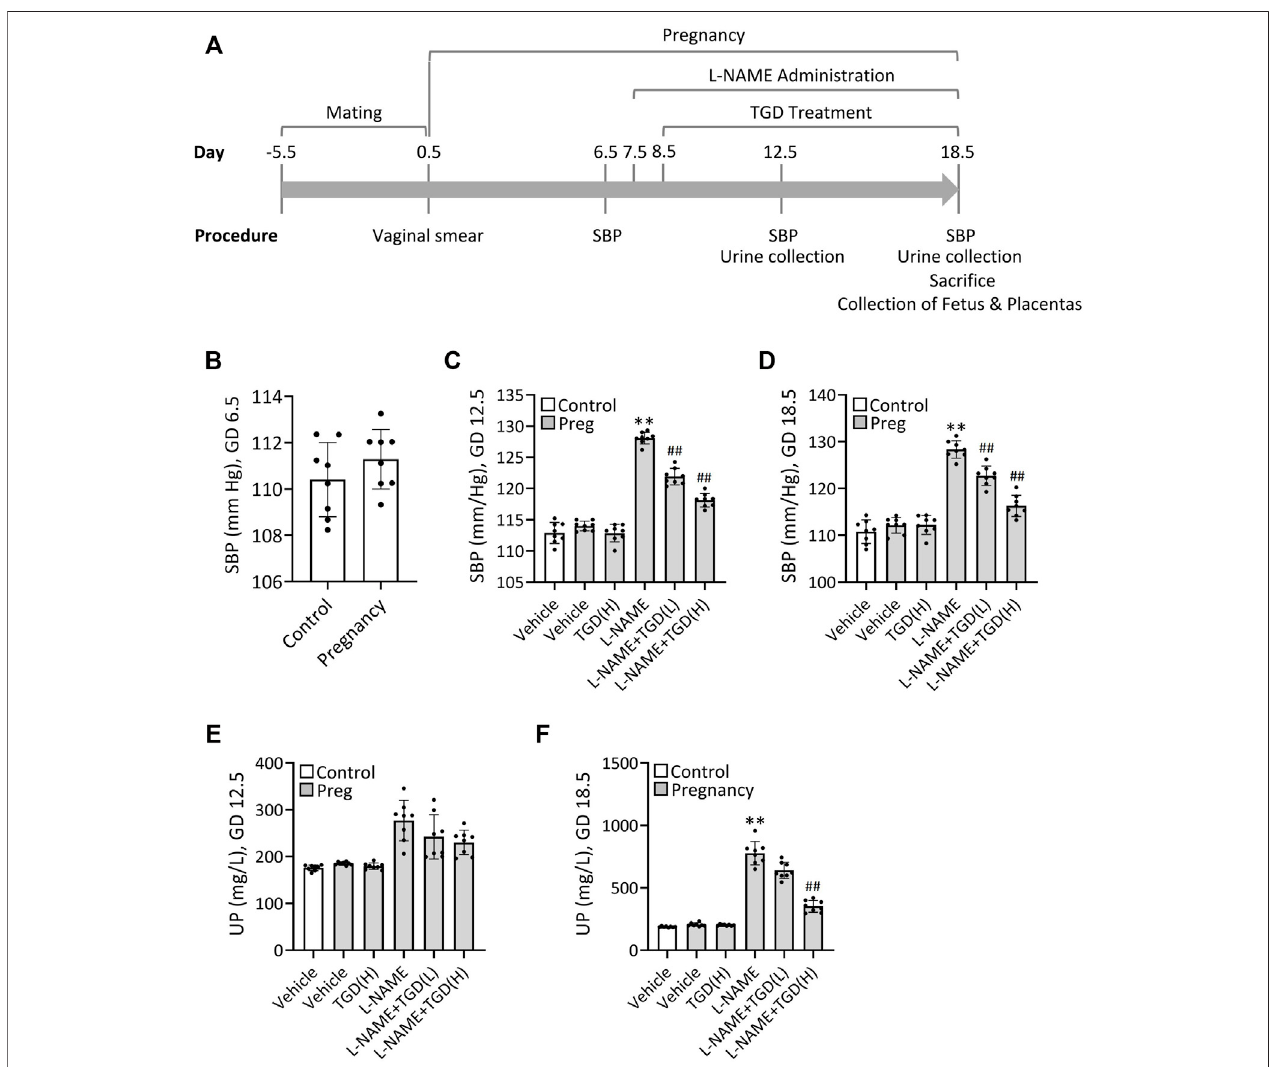
FIGURE 4 | TGD relieves hypertension and decreases urinary protein concentration in a PE mouse model. (A) Schematization of the procedures and treatments included in the protocol over time. SBP, systolic blood pressure. (B) SBP values in unpregnant (control) and pregnant mice (Pregnancy) at gestational day (GD) 6.5. (C) SBPvaluesinunpregnant(control)andpregnantmice(Preg)administratedwithorwithoutL-NAMEandTGDatlowdose(L,20 g/kg/d)orhighdose(H,40 g/kg/d)atGD 12.5. (D) SBP values in unpregnant (control) and pregnant mice (Preg) administrated with or without L-NAME and TGD at low dose (L, 20 g/kg/d) or high dose (H, 40 g/kg/d) at GD 18.5. (E) Urinary protein concentrations (UP) in unpregnant (control) and pregnant mice (Preg) administrated with or without L-NAME and TGD at low dose (L,20 g/kg/d) or highdose (H, 40 g/kg/d) at GD12.5. (F) Urinary protein concentrations(UP) inunpregnant (control)and pregnantmice (Pregnancy)administrated with or without L-NAME and TGD at low dose (L, 20 g/kg/d) or high dose (H, 40 g/kg/d) at GD 18.5.